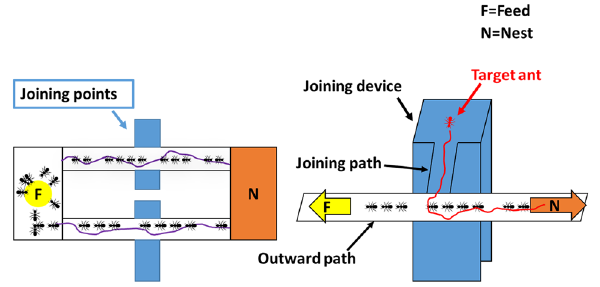
Figure 2. Four joining points (LL, LR, RL, and RR) and the confluence device (joining device). The confluence (joining) device was connected at right angles to the center of the outward and inward bridges of the main apparatus. Here, the LR version is shown as an